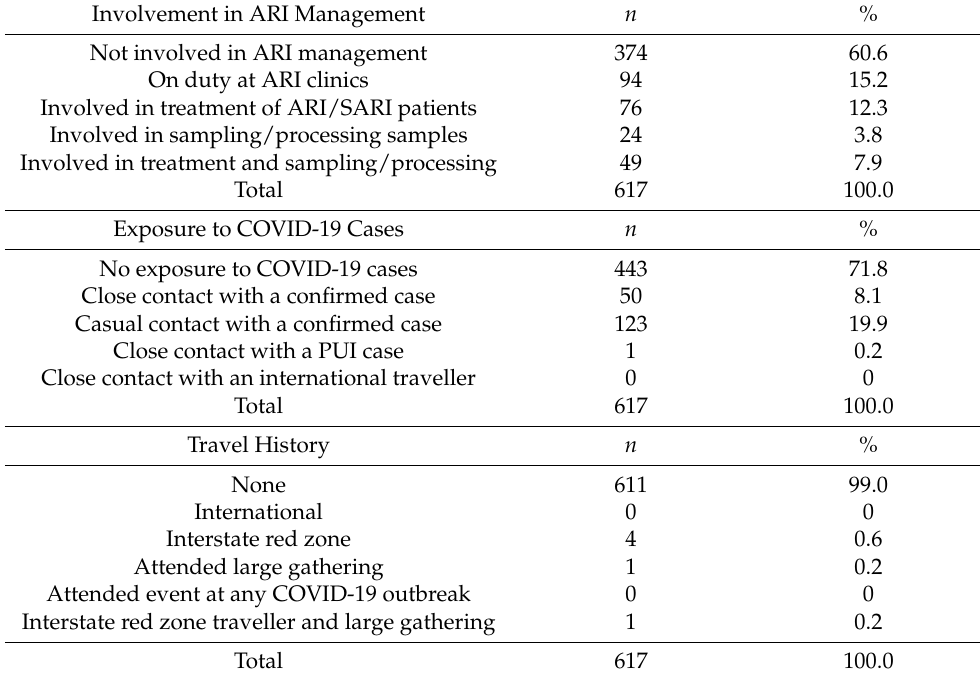
Table 2. History of exposure of the HCWs to